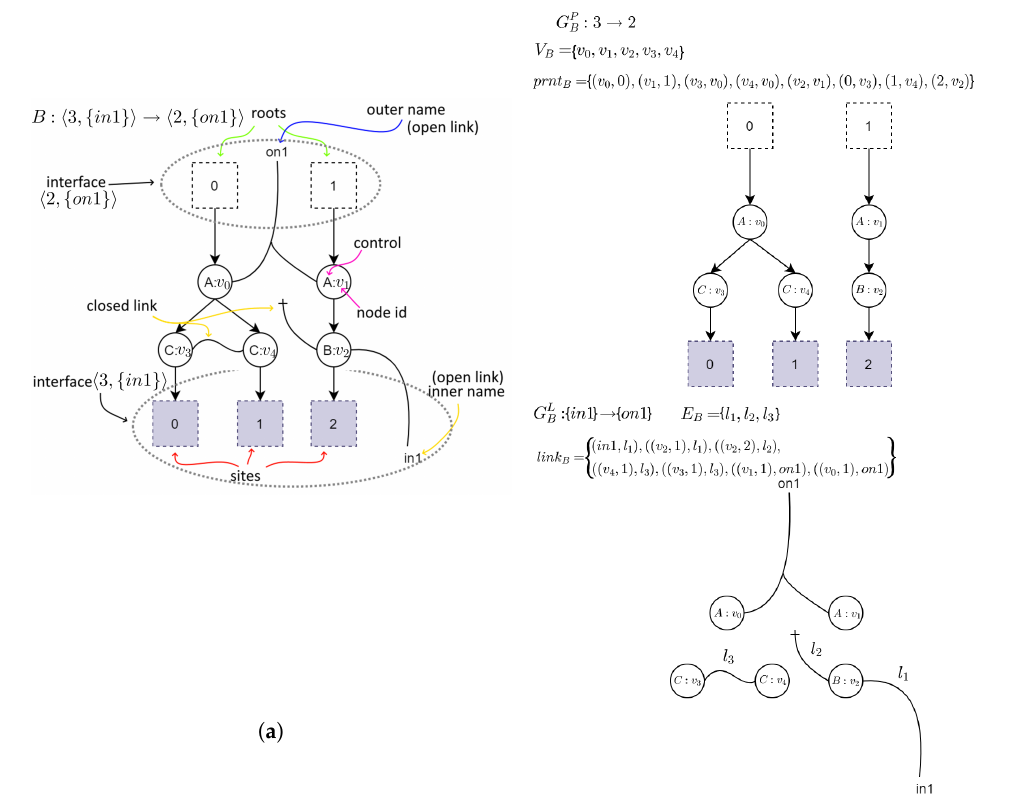
Figure 1. An example of a bigraph and its constituents. The right part represents a place graph (the upper part of the figure) and a link graph (the lower part of the figure). They share a signature which defines control types (letters in nodes) and arity of each control (number of unique links that can be connected to a node with specified control). Ports and inner names can be attached to either edges or outer names, that is why there are only three edge identifiers in the link graph. On the left there is